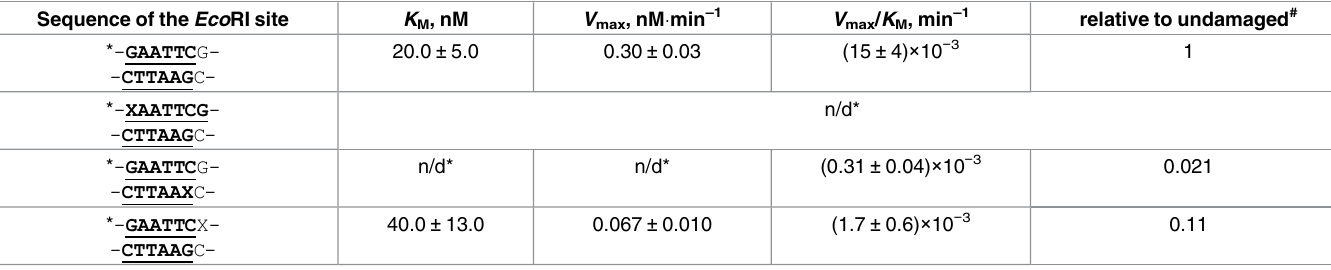
Table 2. Kinetics of EcoRI on oxoG-containing